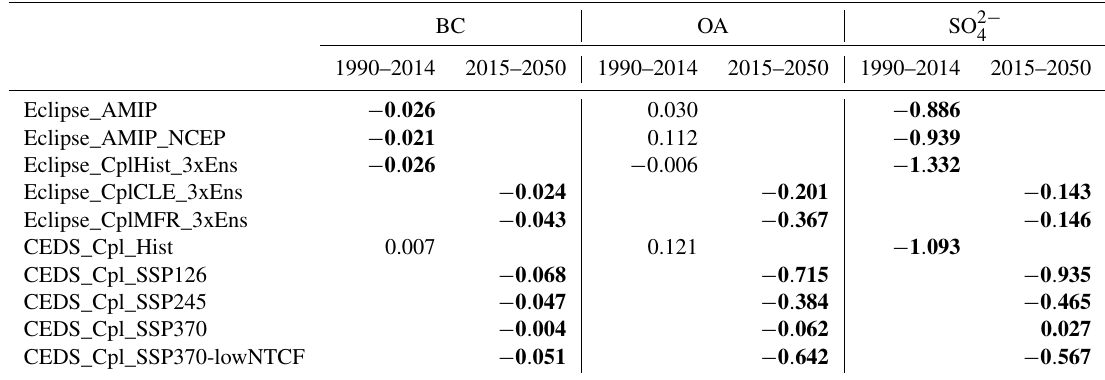
Table 4. Trends in Arctic BC, OA, and SO 2 − burdens in the near past (1990–2014) and future (2030–2050) as calculated by the GISS-E2.1. 4 The bold numbers indicate the trends that are statistically significant on a 95% significance level.